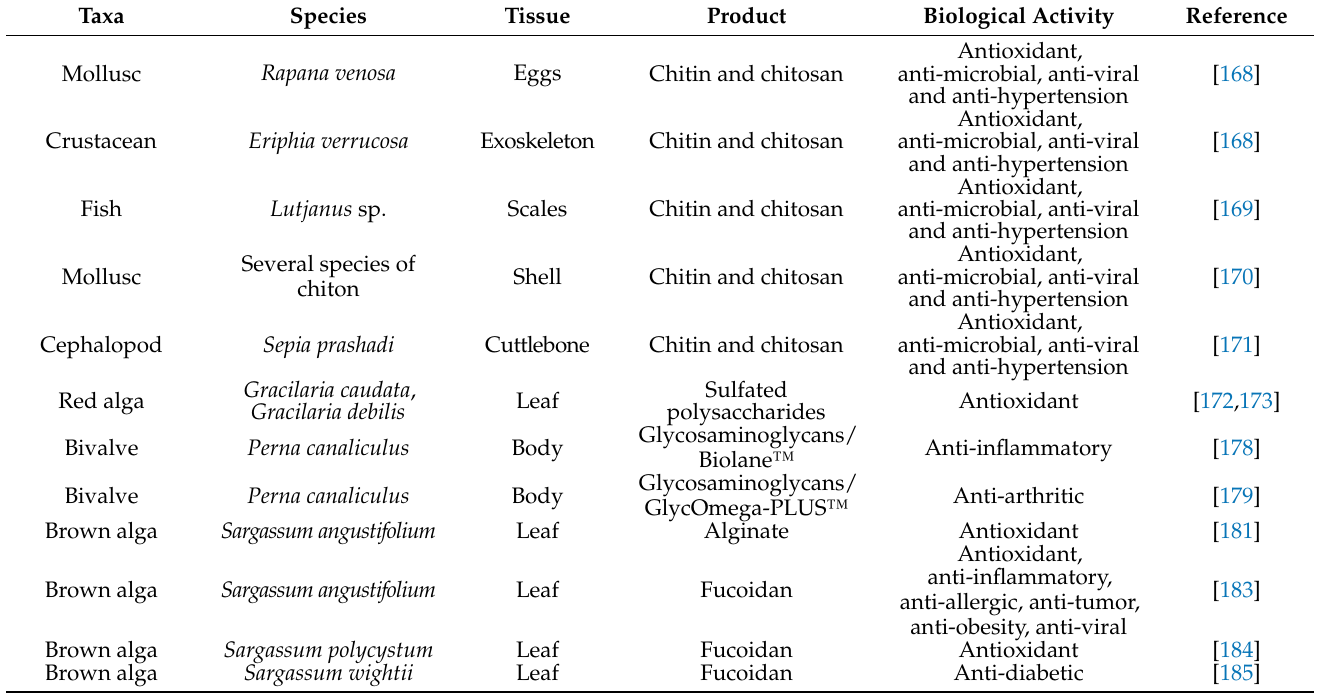
Table 6. Polysaccharides from seafood waste together taxa, species and tissue from which they were isolated, and their biotechnological